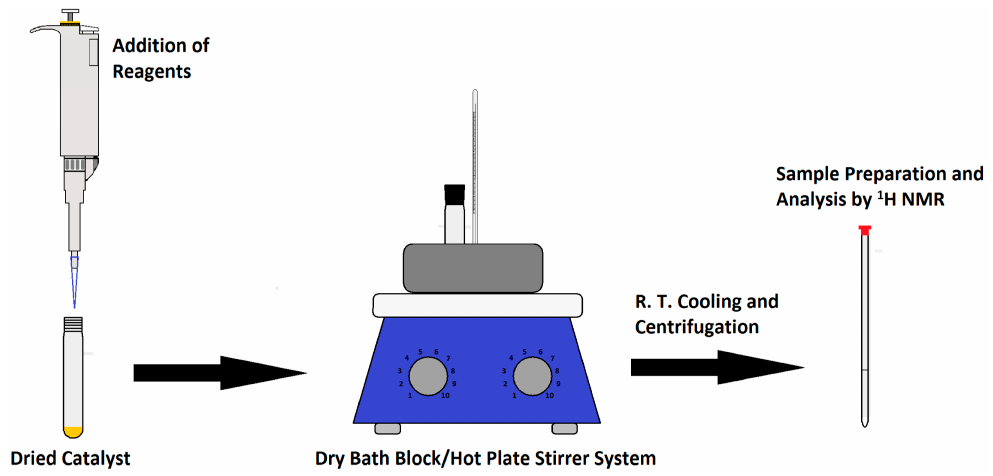
Figure 17. Schematic description for liquid-phase oxidation of BzOH and catalytic measurements.